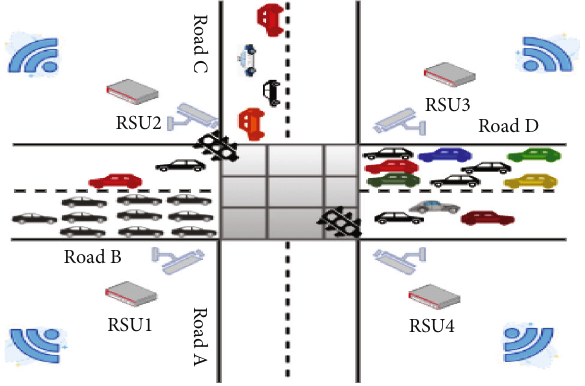
Figure 3: Case study description of road junctions.